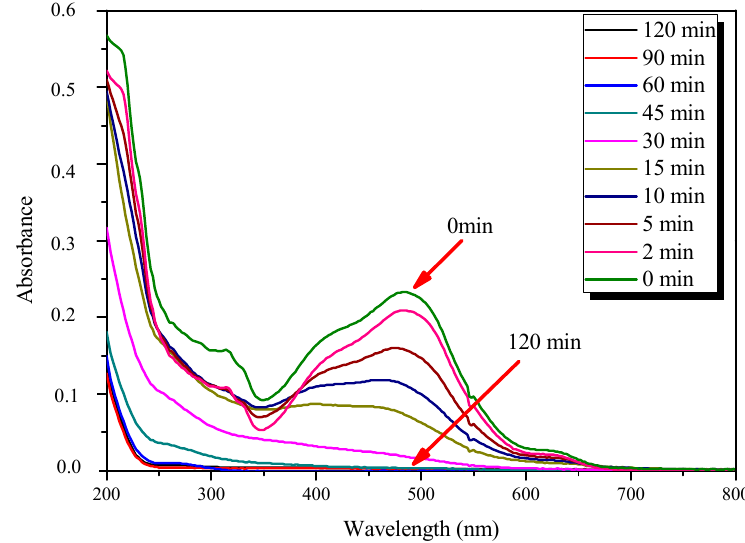
Figure 11. UV–Vis spectra obtained during the commercial aniline “El Sol (S)” photodegradation over F-P25 catalyst.